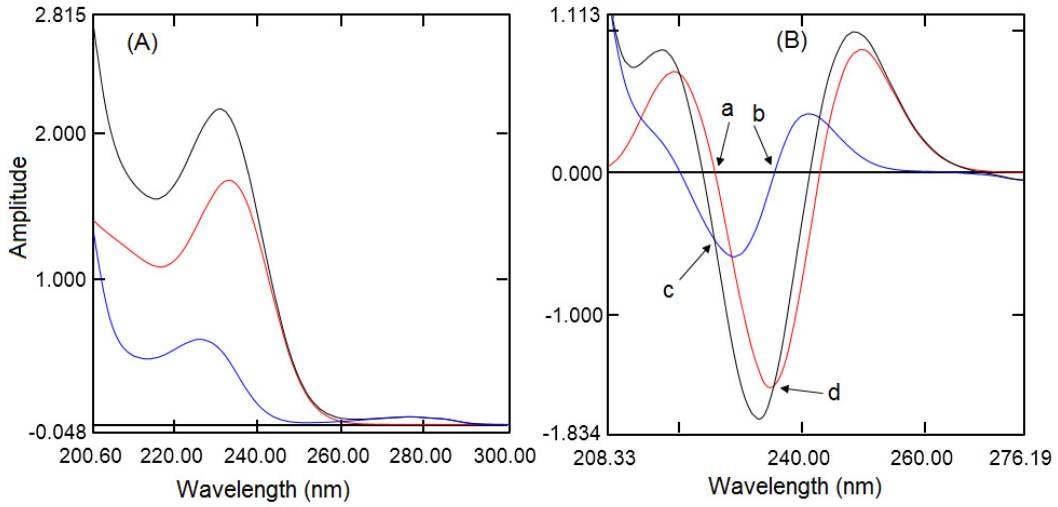
Figure 2. Normal UV absorption spectra of RGE (blue), MFH (red), and mixture (black) ( A ); second-derivative spectra of RGE (blue), MFH (red), and mixture (black) ( B ). Points a and b are zero crossings of MFH and RGE, respectively. Points c and d show the same peak amplitude for RGE and MFH in the pure sample and mixture, respectively.